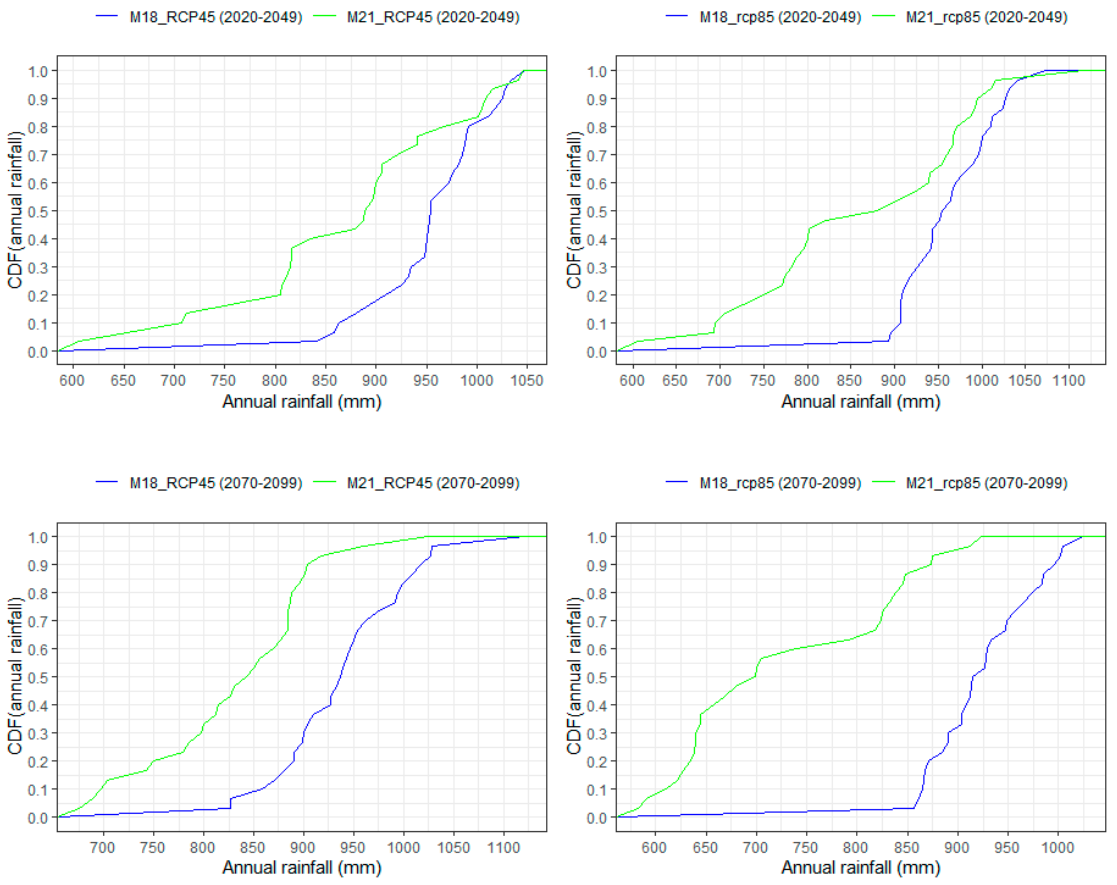
Figure 10. The cumulative distribution function (CDF) of future projected annual rainfall under RCP4.5 and RCP8.5 emission scenarios from the multi-model ensemble (M18) and best performing model (M21) over the two-time horizons (2030s and 2080s).